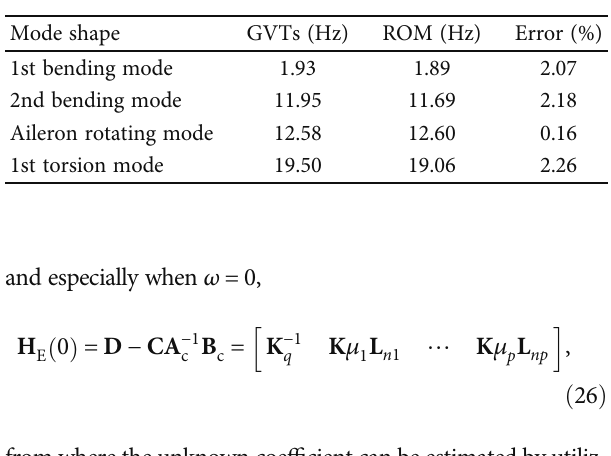
Table 3: Nonlinear parameters of FE model and experimental model. Parameters True Estimation Error (%) Freeplay gap ( ° ) Linear-part sti ff ness (N · m/rad) Table 4: Comparison of natural frequency between the ROM and GVTs.